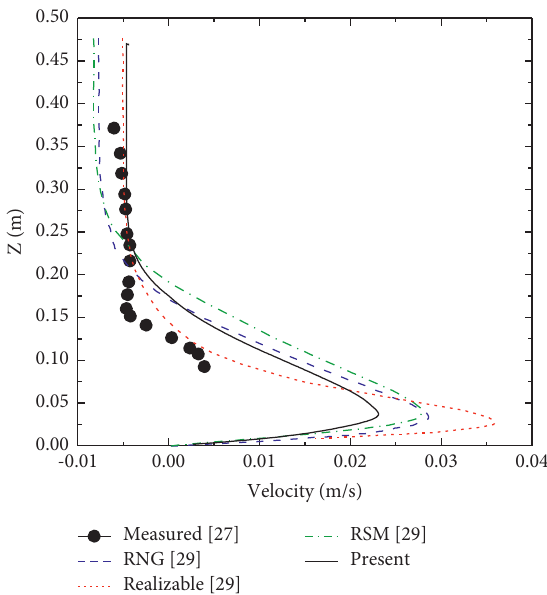
Figure 9: Velocity ux profile at x � 11.43m (see Figure 6 for vertical line position).